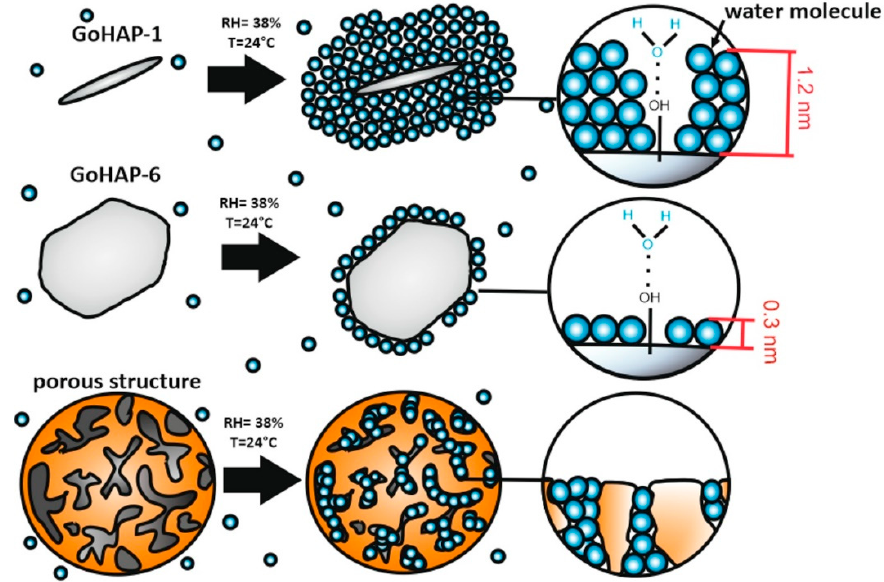
Figure 11. Nanoparticle size and shape effect on water adsorption.